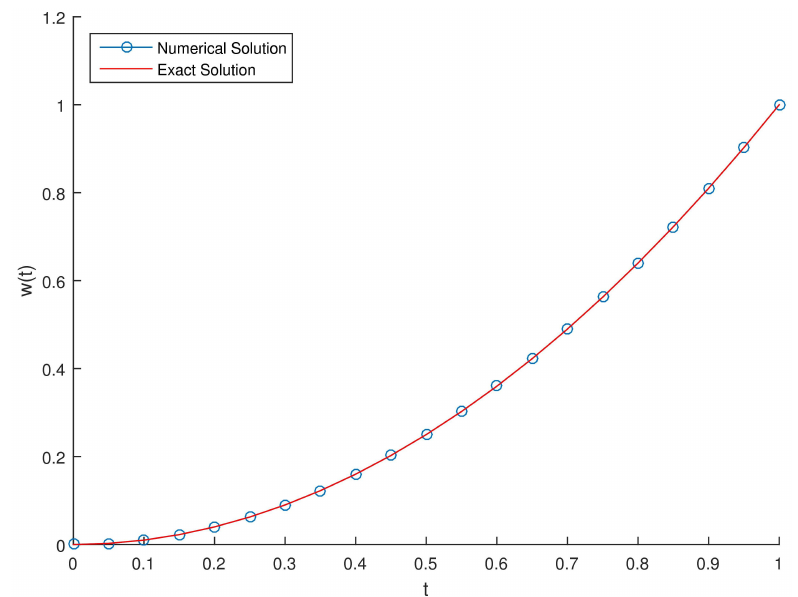
Figure 9. The behaviour of approximate and the exact solutions for Example 3.